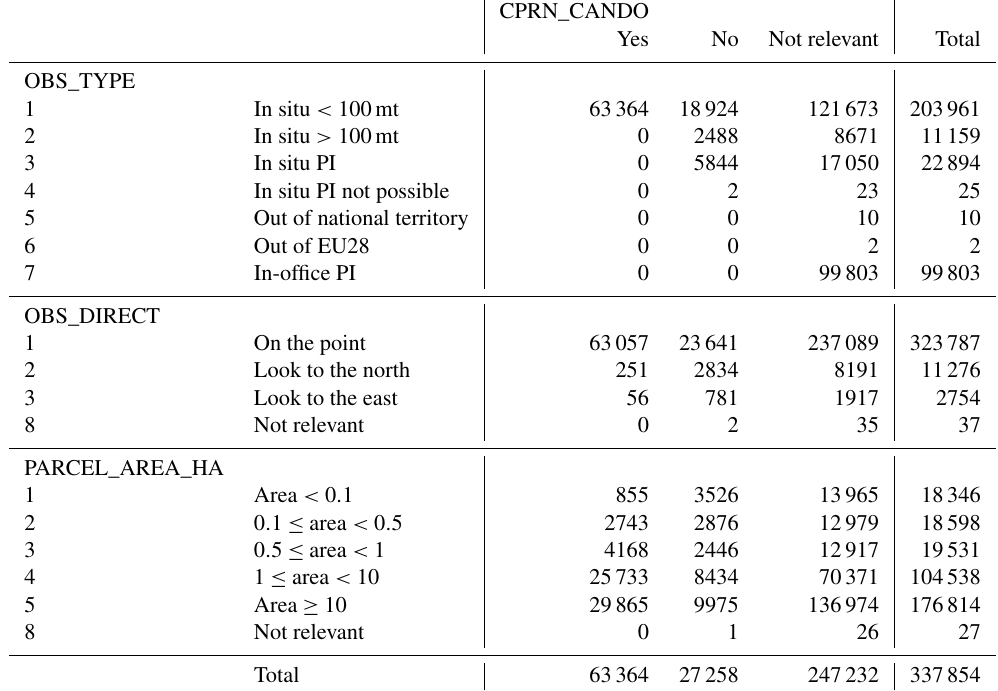
Table A1. Copernicus survey with relation to observation type (OBS_TYPE), observation direction (OBS_DIRECT), and parcel area (PAR-